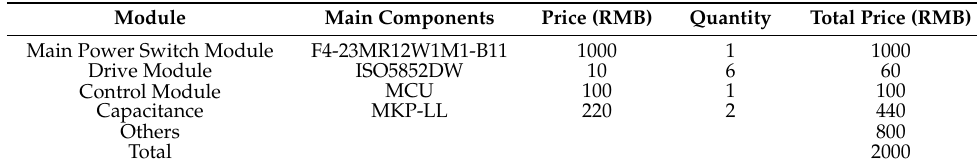
Table 3. Primary inverter electronic power components.